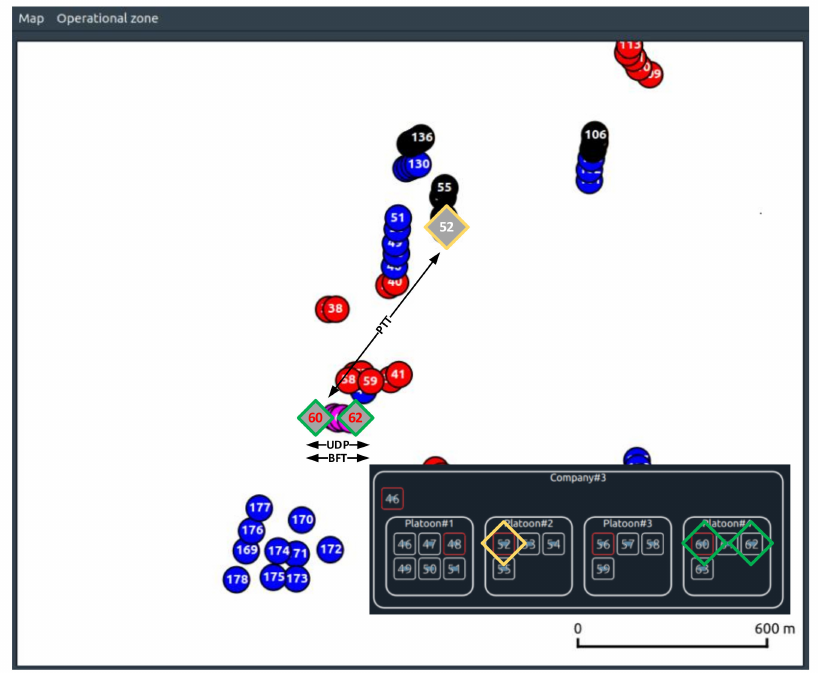
Figure 16. Command relation between 60–62